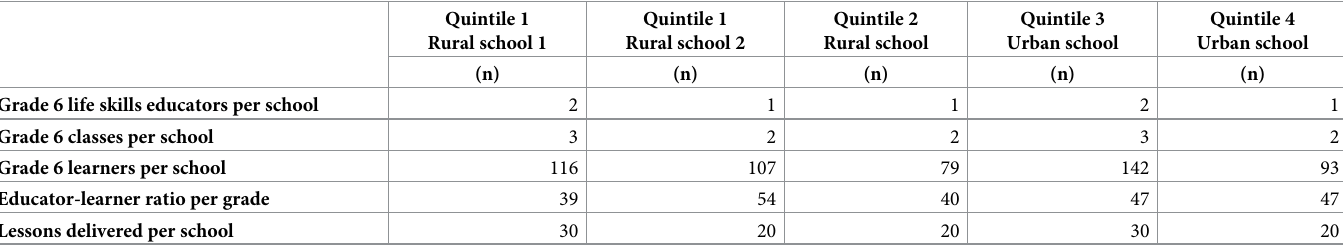
Table 2. Descriptive information about participating schools, classes and